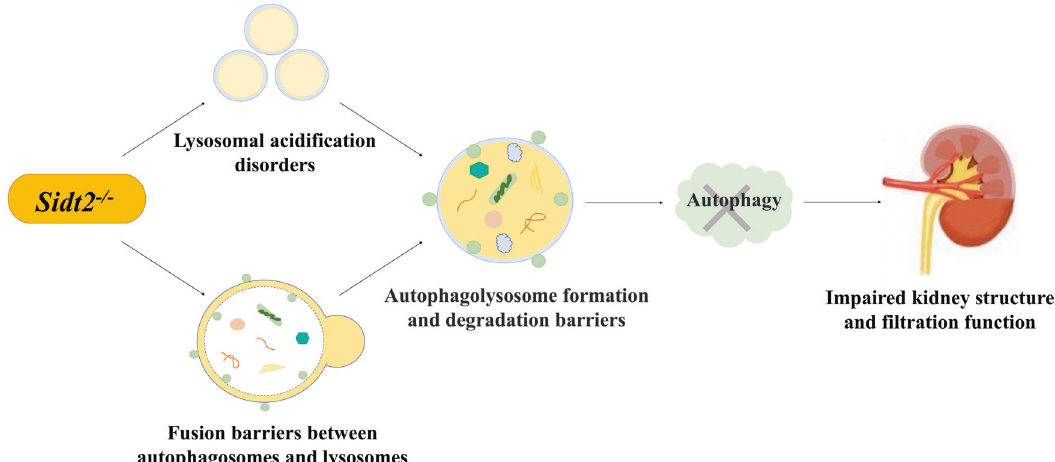
Fig. 8 Sidt2 deletion causes renal autophagy, structure, and function impairments. The deletion of Sidt2 gene leads to lysosomal acidi fi cation disorders, and the fusion of autophagosomes and lysosomes is blocked, which leads to the formation and degradation barriers of autophagolysosomes. Impaired autophagy ultimately leads to impaired kidney structure and fi ltration